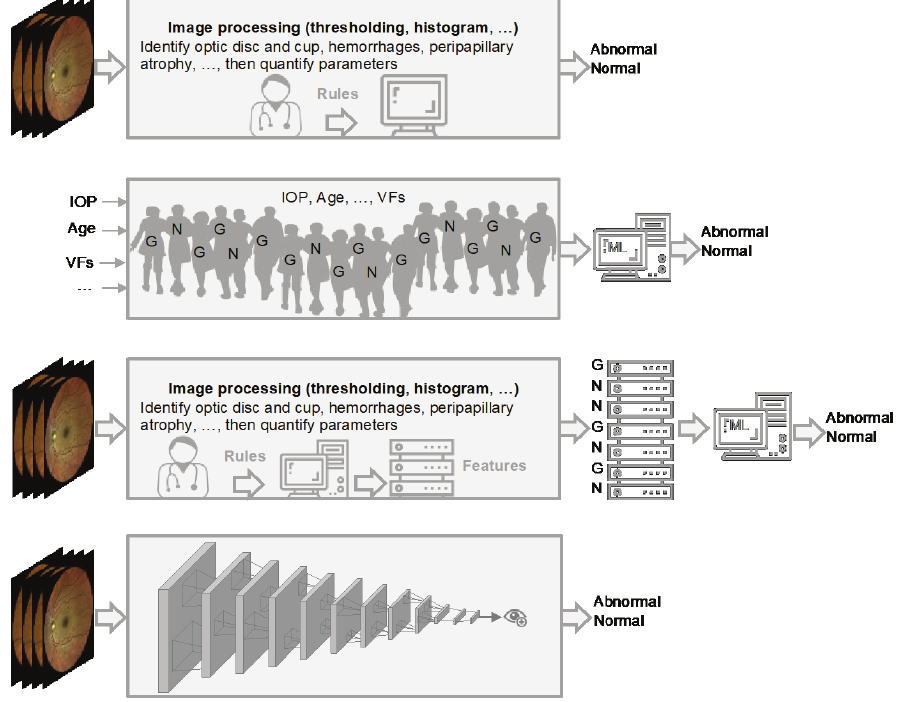
Figure 2. Evolution of AI in glaucoma. First row : Image processing and expert systems were used to identify glaucoma landmarks or features (such as cup-to-disc ratio or hemorrhages) from retinal images with the assistance of a glaucoma specialist and glaucoma landmarks are identified. Second row : Numerical parameters like raw visual fields (VFs), intraocular pressure (IOP), and age from normal and glaucomatous subjects (presented as N and G ) are input to a conventional machine learning model (e.g., neural network) without glaucoma specialist assistance and diagnosis is made. Third row : Image processing and expert systems were used to quantify glaucoma landmarks (extract features) with the assistance of a glaucoma specialist then quantified parameters (features) from normal and glaucomatous subjects are fed to a conventional machine learning model to make diagnosis. Fourth row : Retinal image is fed to an end-to-end deep learning model and the diagnosis is made without assistance from a glaucoma